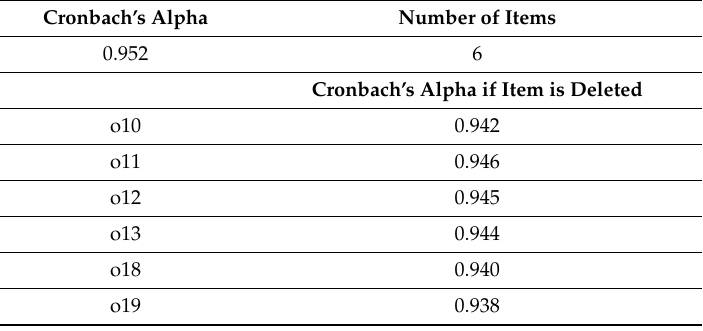
Table 5. Reliability analysis for factor